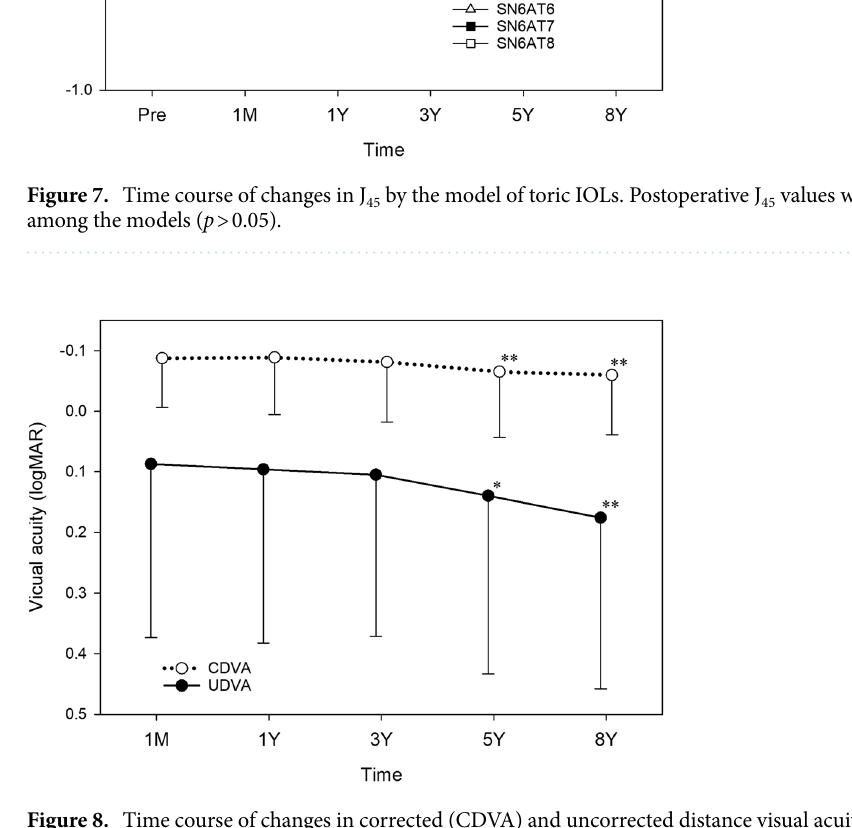
Figure 8. Time course of changes in corrected (CDVA) and uncorrected distance visual acuity (UDVA). Both UDVA ( p < 0.001) and CDVA ( p < 0.001) showed significant changes after surgery. UDVA at 5 years (* p = 0.004) and 8 years (** p < 0.001) postoperatively was significantly worse than UDVA at 1 month postoperatively. CDVA at 5 years (** p < 0.001) and 8 years **( p < 0.001) after surgery was significantly worse than CDVA at 1 month postoperatively. logMAR logarithm of minimum angle of